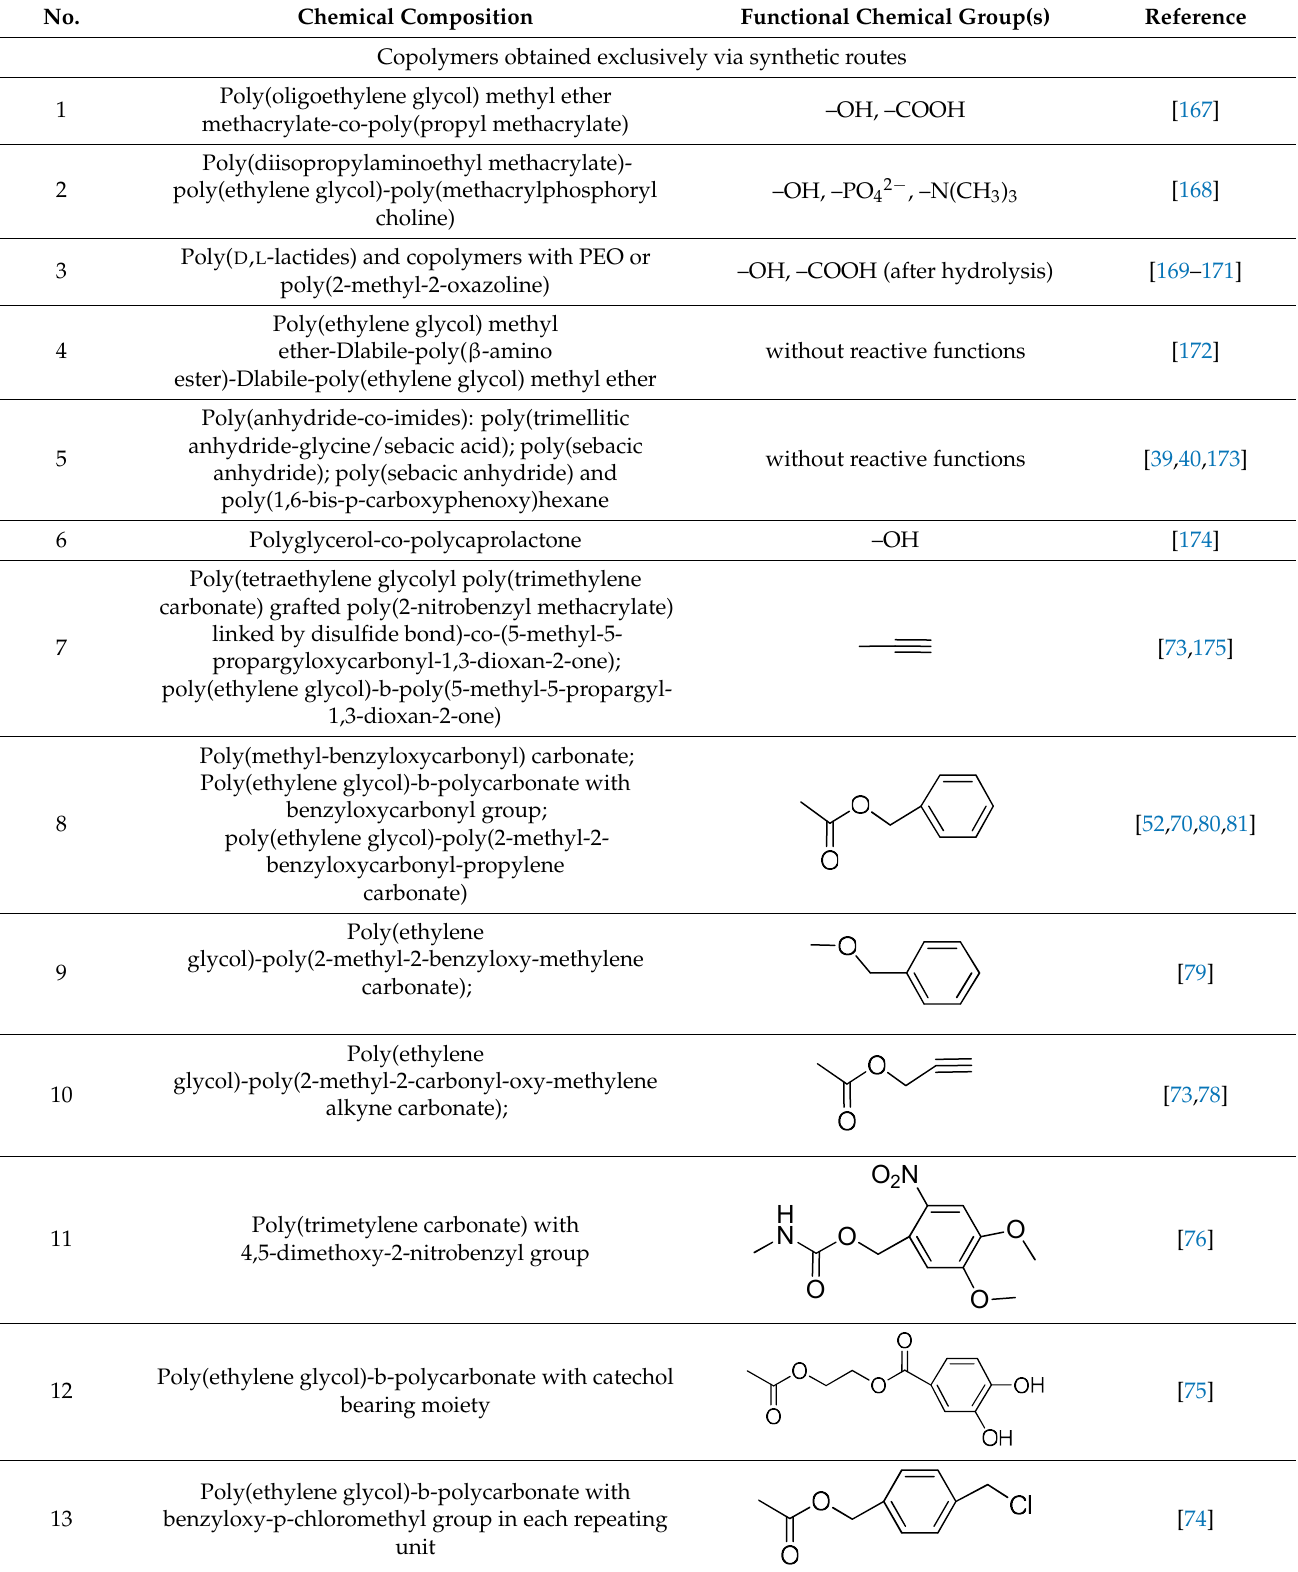
Table 1. Examples of synthetic and natural polymers/copolymers used for preparation of particles with/without functional groups for drug delivery systems.